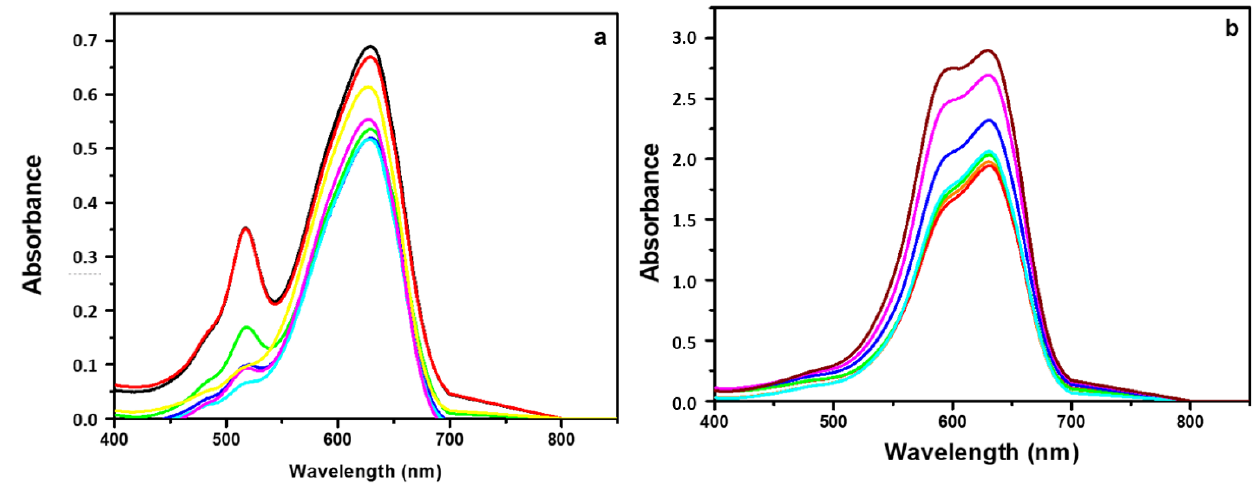
Figure 9. UV-Vis time-dependent absorption spectrum during the photocatalytic reaction of ( a ) MB dye, and ( b ) o-TB for 1:1 ratio.